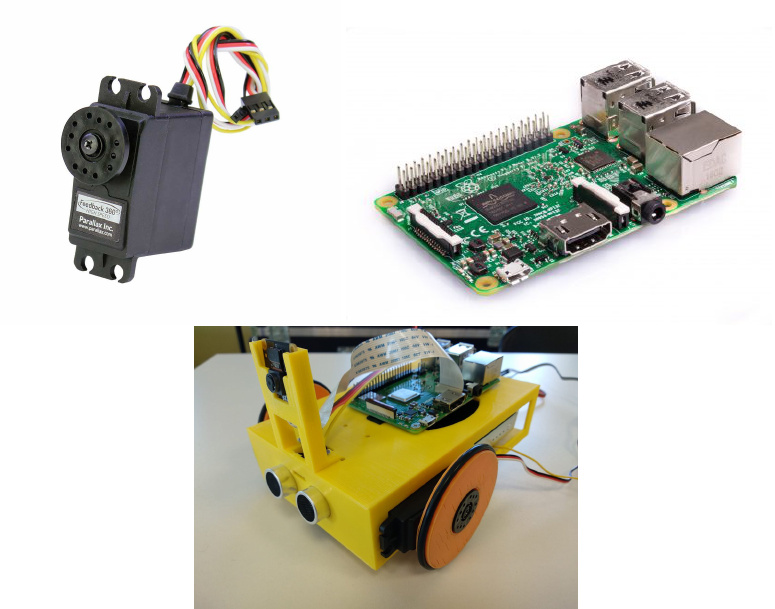
Figure 5. Motors, Raspberry Pi board and PiBot made with 3D printable